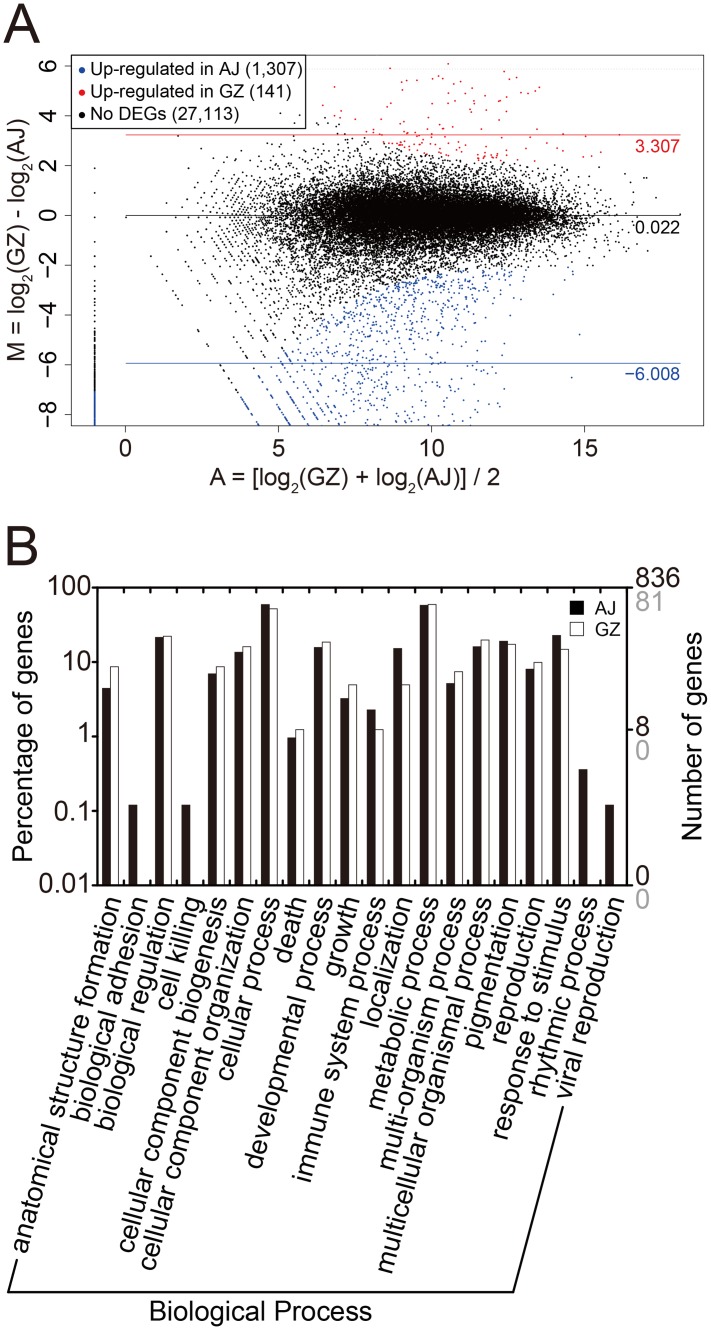
Differentially expressed genes between AJ and GZ spike tissues.(A) MA plot of differentially expressed transcripts identified in AJ and GZ. The X axis represents the mean expression level, and the Y axis represents the log2 fold-change of GZ transcripts over AJ. Red and blue dots represent differentially expressed genes (DEGs) that are significantly abundant in GZ and AJ, respectively, at p-value < 0.05. Horizontal lines and the values to the right represent the average M-values of corresponding groups of DEGs and non-DEGs. (B) Gene ontology (GO) classification of the DEGs. GO terms of Z. japonica unigenes are based on significant hits against the NR database. The right y-axis indicates the number of upregulated genes in AJ (black) and GZ (grey), respectively. The left y-axis indicates the percentage of each group from the total.